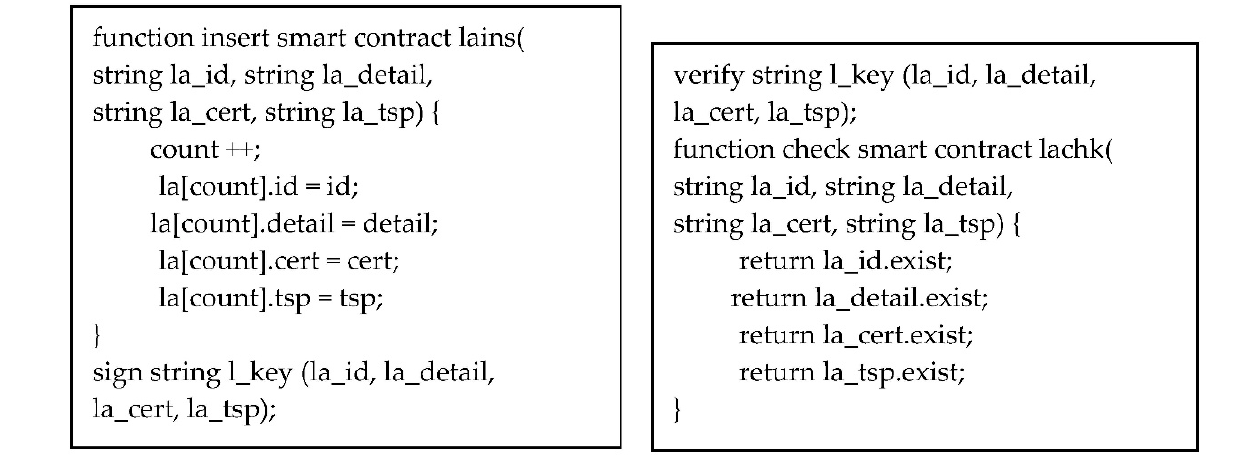
Figure 7. Authentication and issuing invoice phase (L to